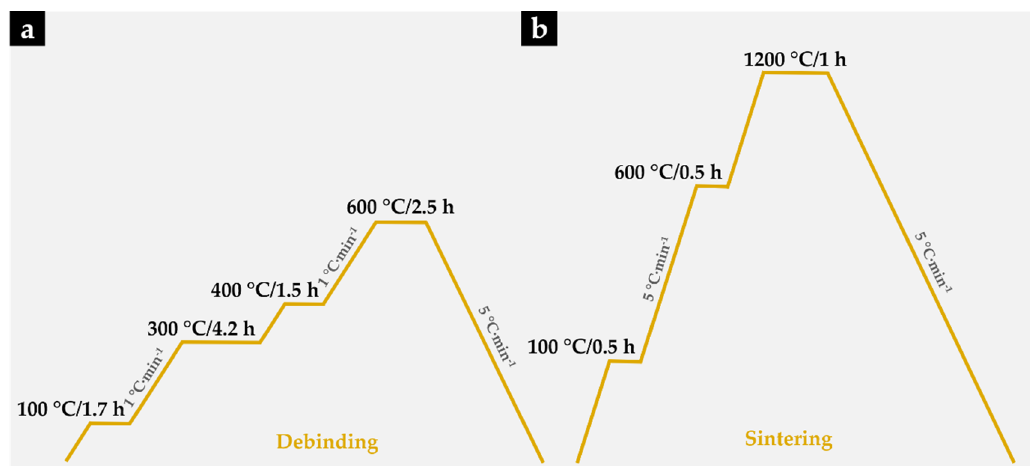
Figure 2. Debinding and sintering thermal cycles applied to Fe–WC compacts. ( a ) The thermal cycle carried out during debinding; ( b ) The applied thermal cycle with heating and cooling rates of 5 ◦ C · min − 1